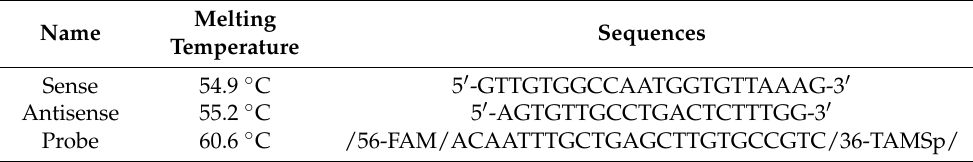
Table 1. HCoV-229E primers with their respective sequences and melting